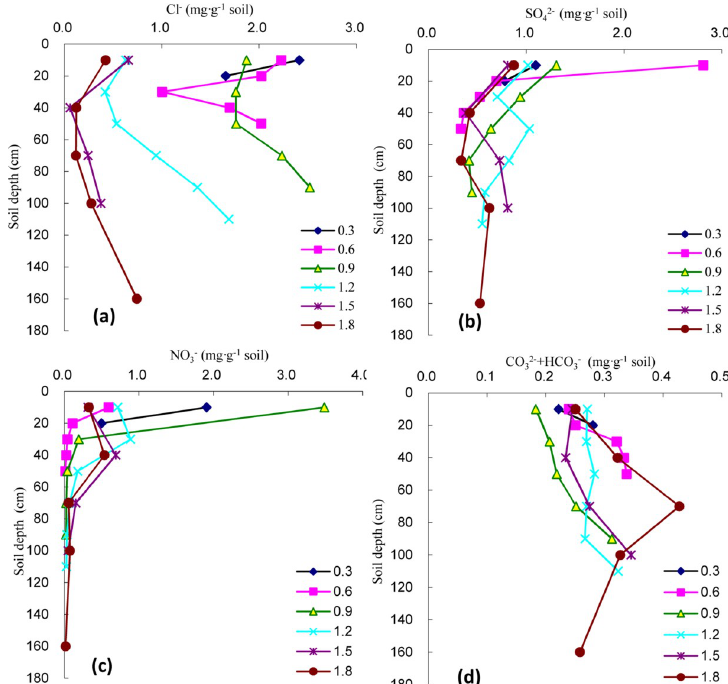
Fig 4. Changes of soil salt anion under different groundwater level in soil profiles. (a) Cl - ; (b) SO 42- ; (c) NO 3- ; (d) CO 32- +HCO 3- .